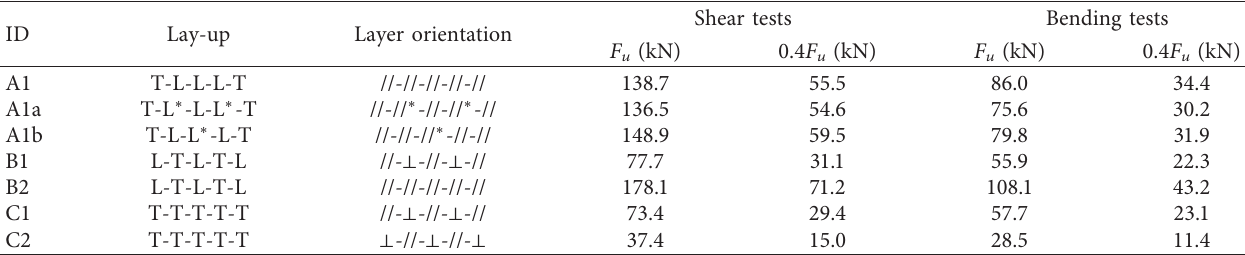
Figure 3: DIC areas in bending test and related shear and bending Table 3: Failure loads and loads for strain evaluation of lay-ups.